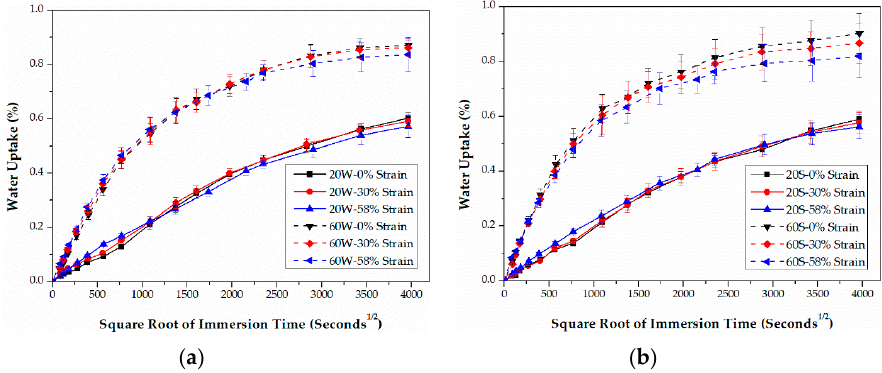
Figure 6. Water uptake curves of PU-based CFRPs immersed in distilled water ( a ) and seawater ( b ) for 6 months, respectively.